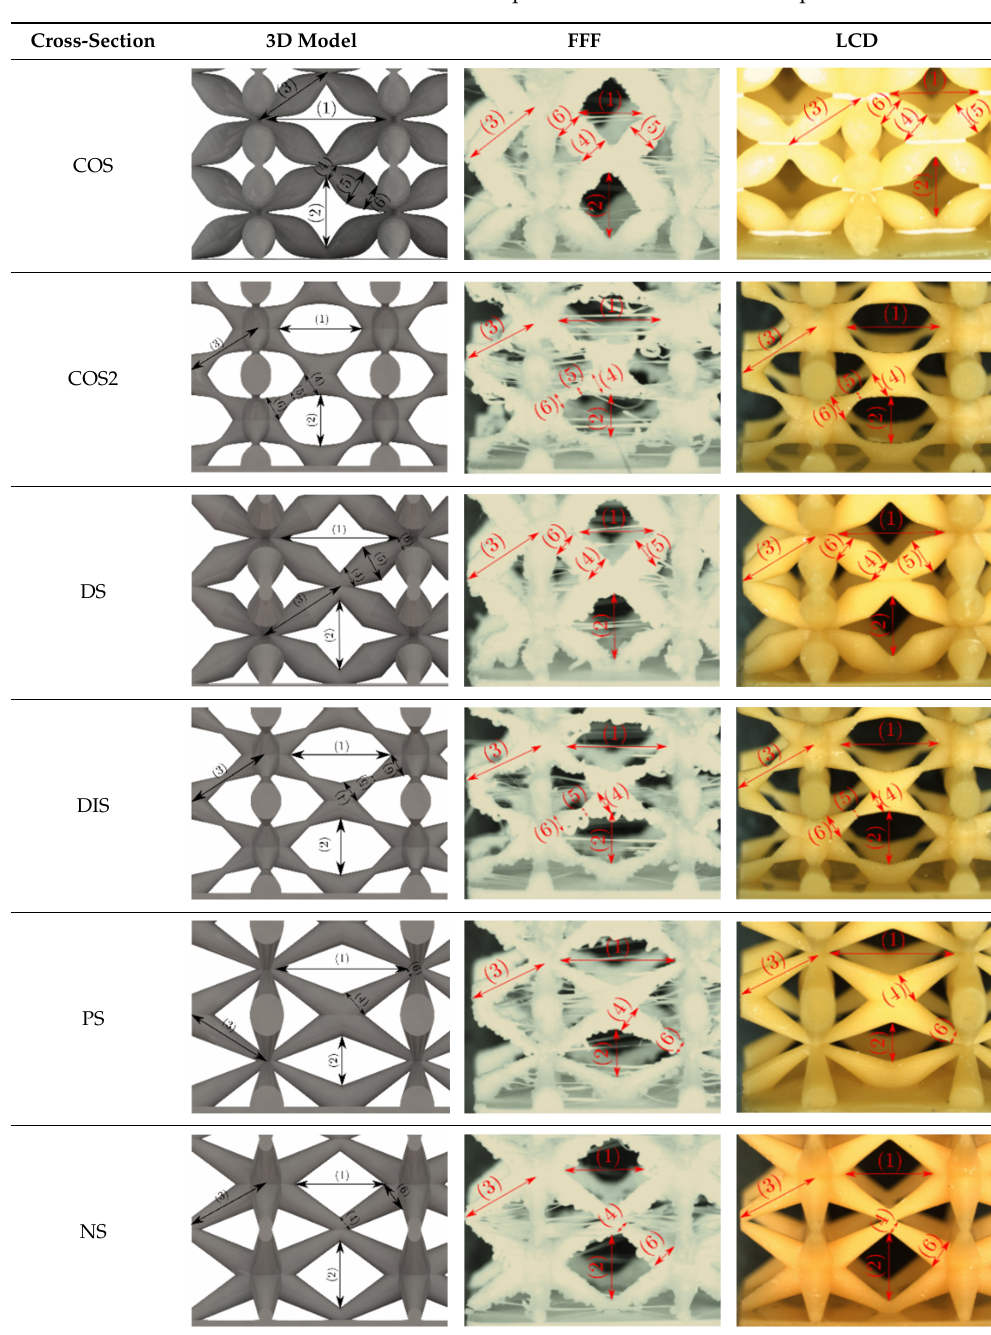
Table 1. Identification of the dimensions of the 3D printed models with the computational